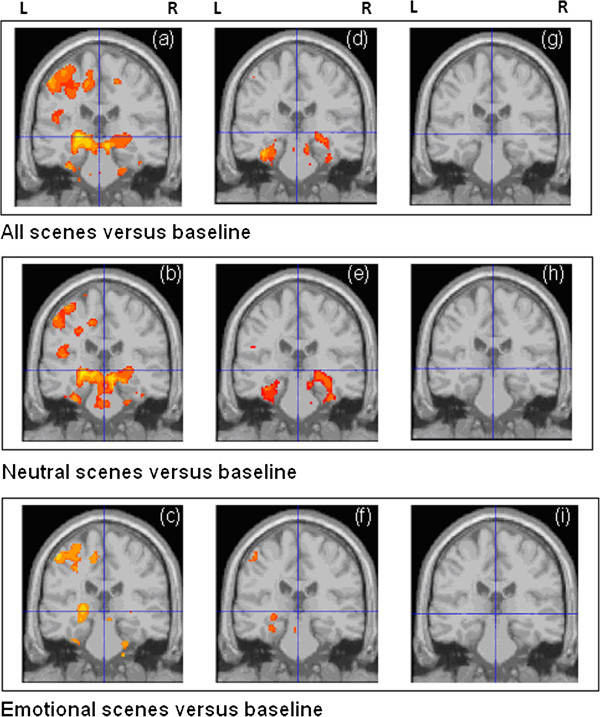
Within group activation maps for HC (a, b, c), MCI patients (d, e, f) and AD patients (g, h, i). Images thresholded at p = 0.01 uncorrected for illustration purposes only, all statistical comparisons performed at p = 0.001 uncorrected threshold, as described in methods section.